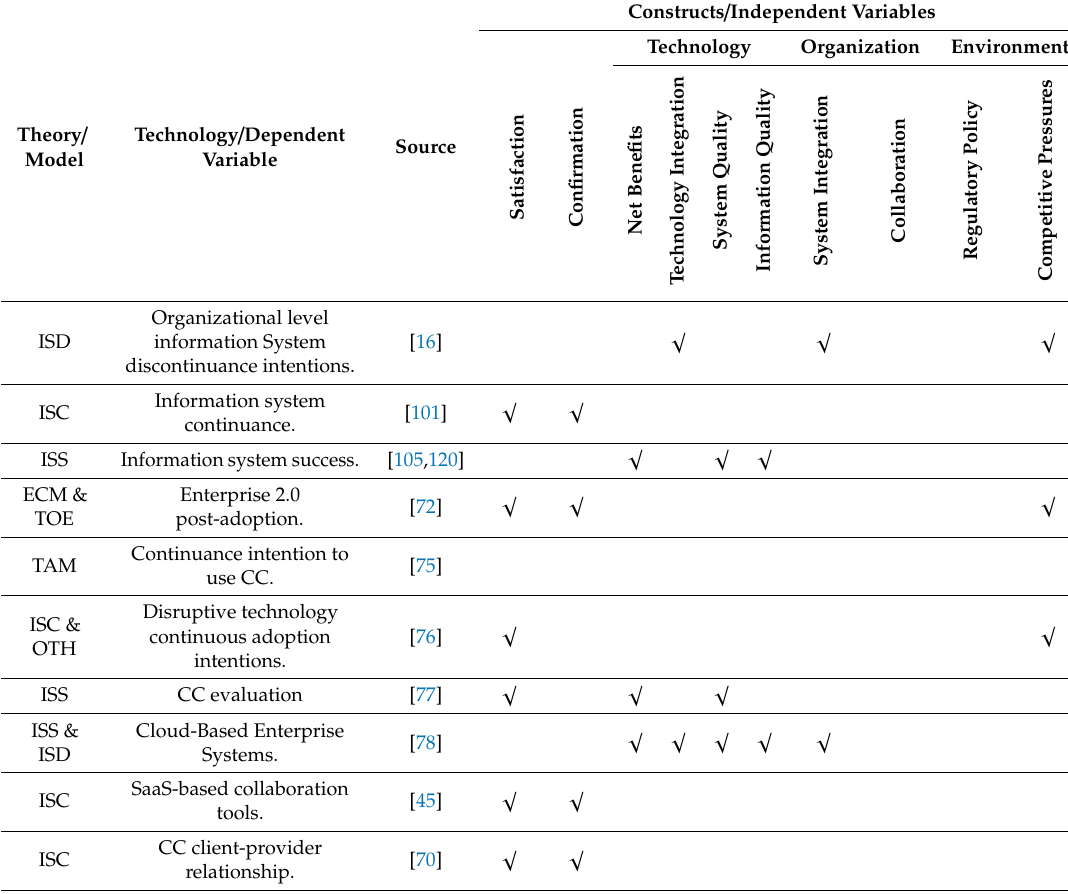
Table 3. Mapping matrix of model constructs from ISC, ISS, ISD, and